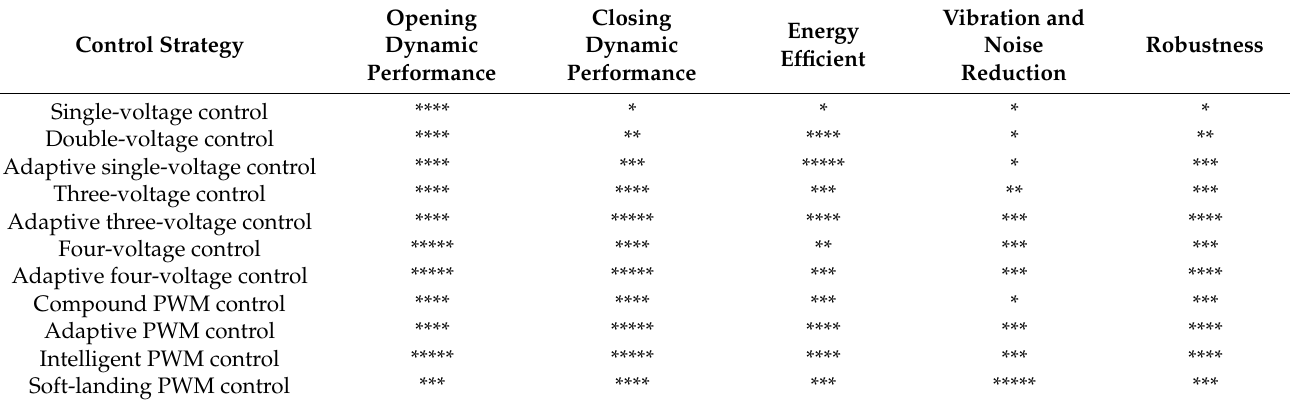
Table 1. Performance comparisons of the control strategies for a single